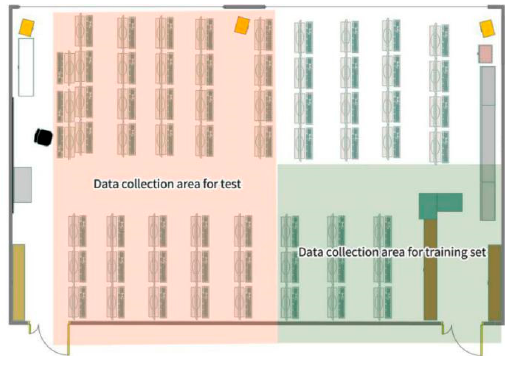
Figure 1. Experimental test environment.